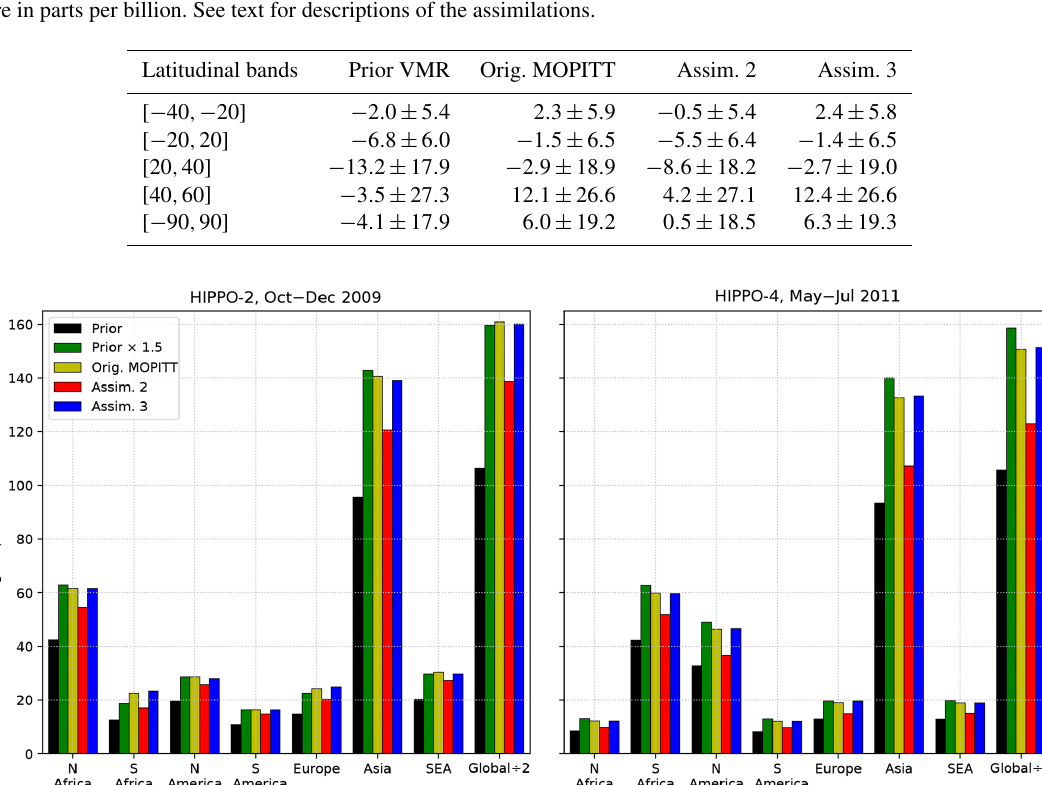
Figure 9. Emission estimates from assimilations in GEOS-Chem adjoint model for two different times. For this figure, global emissions are scaled down by 2. SEA is southeastern